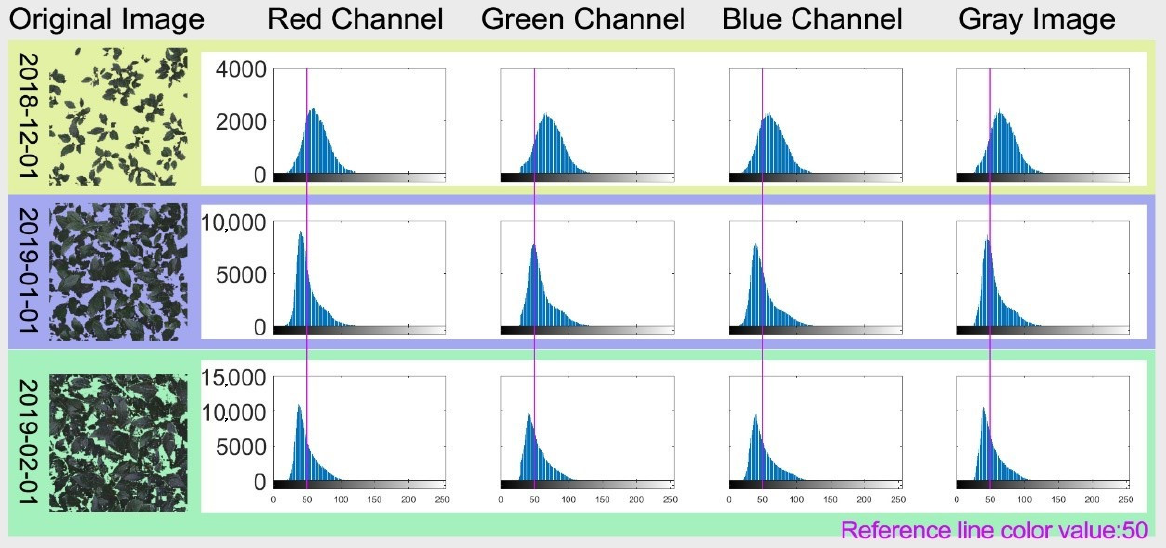
Figure 4. RGB model color gradation distribution of population canopy images of BFH on 3 different dates. The cumulative frequency histogram of red, green, and blue channels, as well as gray-level images, were drawn using the imhist function of MATLAB. The X-axis is the color gradation value, and the Y-axis is the cumulative frequency.